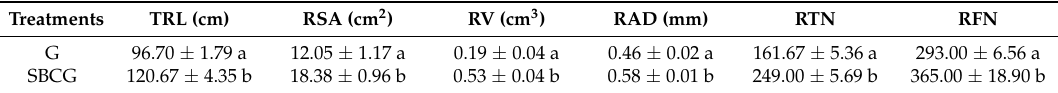
Table 6. Summary of root growth indices of alfalfa after incubation (mean ± S.V. (standard deviation), n = 3).